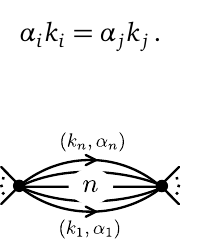
. The Landau equation i